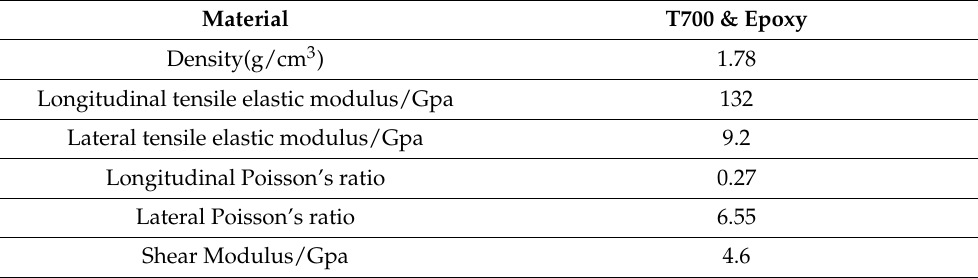
Table 2. Performance parameters of carbon fiber-reinforced polymer (CFRP).